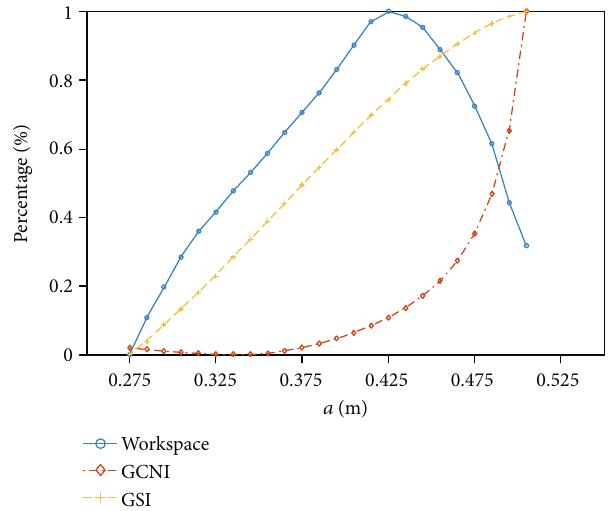
Figure 7: Trends of performance in di ff erent con fi